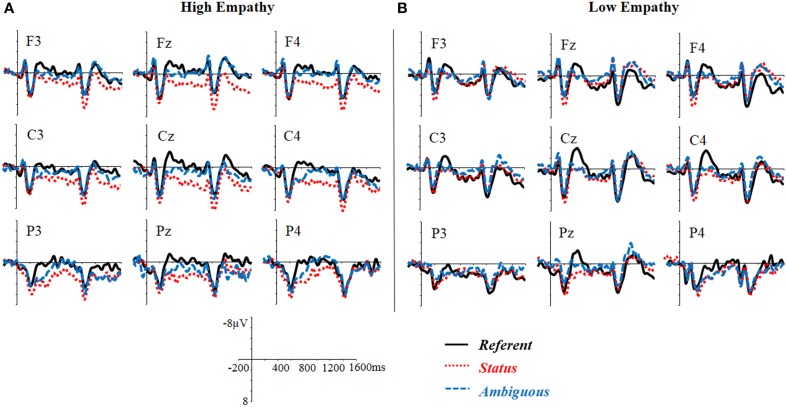
Grand average waveforms time locked to the pronoun on 9 representative electrodes for the three critical conditions in the high-empathy (A) and the low-empathy (B) individuals. The high- and the low-empathy individuals were defined according to the median split of the empathy score (Median = 39). Those with EQ lower than 39 were defined as low-empathy individuals (n = 14, Mean = 30.43, ranging from 16 to 37) while those with EQ higher than 39 were defined as high-empathy individuals (n = 15, Mean = 48.33, ranging from 41 to 61). Three individuals with EQ equal to 39 were not included in the figure.